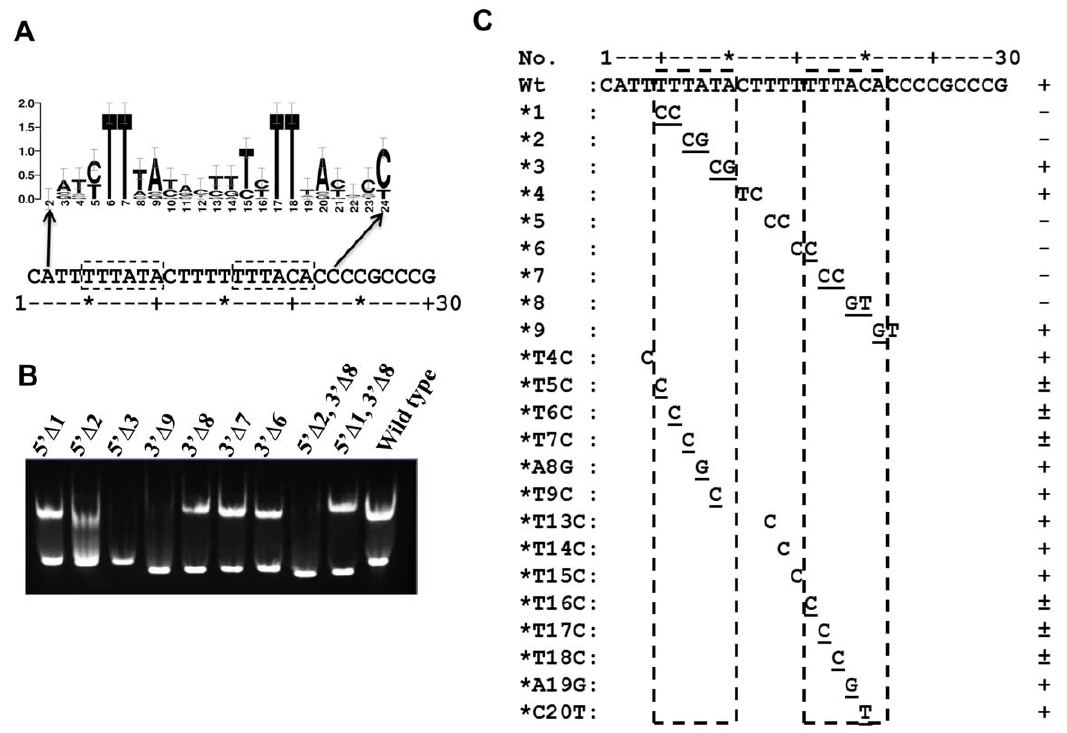
Figure 4. Identification and characterization of half-sites S1 and S2 on DNA that interacts with KdpE DBD . A. Sequence logo representation to highlight conserved sequences in a 24 bp stretch of kdpFABC BS . In the logo, the height of the letter represents its frequency of occurrence in a multiple sequence alignment (Fig. S3) and the error bars indicate the sampling error at individual positions. Two 6 bp imperfect direct repeats (TTTATA and TTTACA) separated by a 5 bp sequence are shown in dashed boxes below the logo. B. Identification of the minimal length of DNA required for binding KdpE. For EMSA, double-stranded DNA molecules with progressive deletions (indicated by D ) at either 5 9 , 3 9 , or both ends were used (the nomenclature for oligonucleotides: 5 9 D 2, 3 9 D 8 (Fig. 4B, lane 9) refers to deletion of 2 and 8 bp from the 5 9 and 3 9 ends respectively of the wild-type (30 bp) DNA molecule; oligonucleotides used are shown in Table S2). The interpretation of EMSA was qualitative: discreet band shifts as observed in Fig. 4B, lane 1 were considered a positive reaction ( + ), whereas no shift (Fig. 4B, lane 3) was scored negative ( 2 ) and smeared bands as exemplified by Fig. 4B, lane 2 were considered partial binding. C. Effects of changes in DNA sequence on the KdpE DBD -DNA interaction. A summary of EMSA data (data not shown) using the 30 bp kdpFABC BS sequence and modified oligonucleotides (only specific two or one nucleotide substitutions are noted) are presented. The scoring of EMSA analysis was as described above. The dashed boxes represent the 6 bp direct repeats that form half- sites S1 and